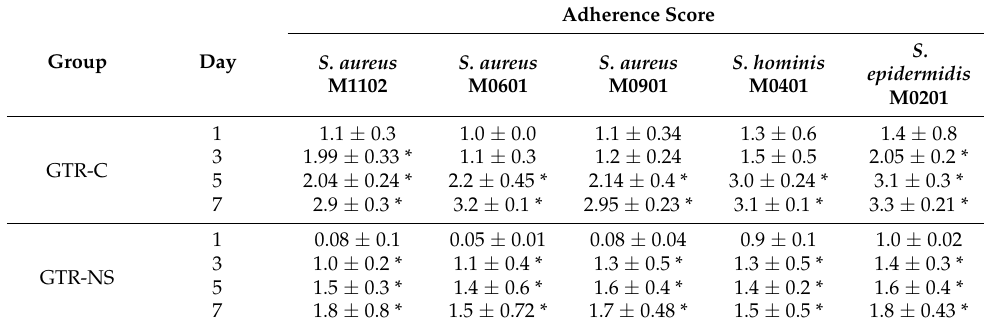
Table 5. Qualitative assessment of bacterial adherence.